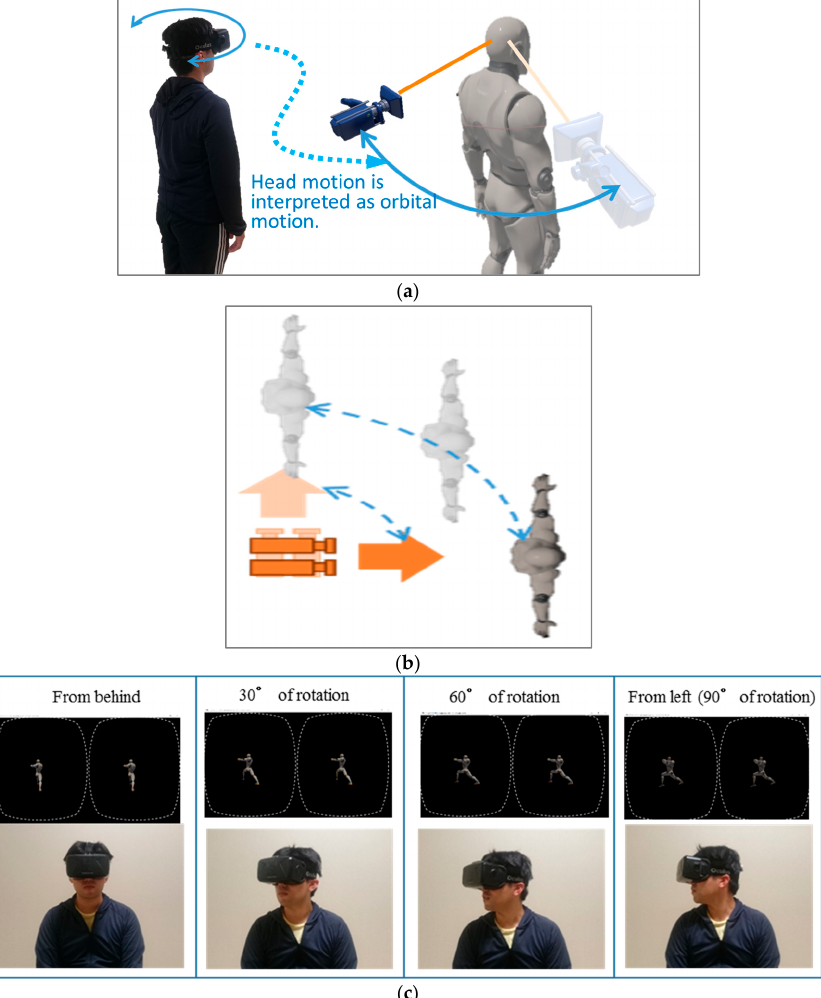
Figure 1. Head motion-associated virtual stereo rearview (HMAR) can be understood in the following two modes. ( a ) The avatar-centered perceptual mode: in this scheme, the camera corresponding to the observer’s viewpoint is understood as the camera, i.e., the observer is swung around the avatar’s body axis in accordance with the observer’s head rotation. ( b ) The observer-centered perceptual mode: in this case, the observer feels as if their body is stationary, and just rotates their head, while the avatar is swung around the observer without autorotation. ( c ) Upper photographs show an example of the head-mount-display (HMD) stereo rearview. Lower photographs show an HMD-wearing subject. The stereo review was continually presented along with the learner’s head rotation in the HMAR system.